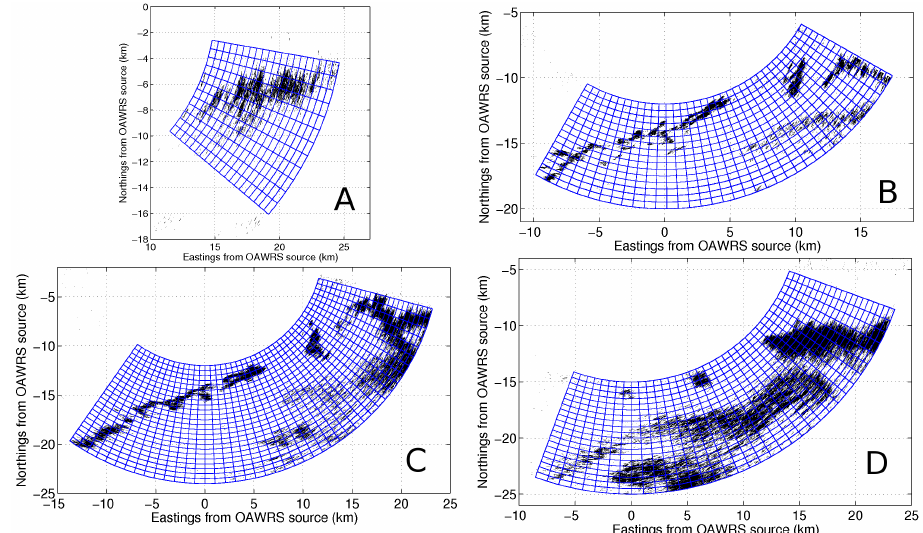
Figure 2. Spatial shoal segmentation pattern. The segmentation pattern is swept by a unit annular sector covering 4 × 4 grid area for analysis. A unit annular sector contains roughly 270 independent